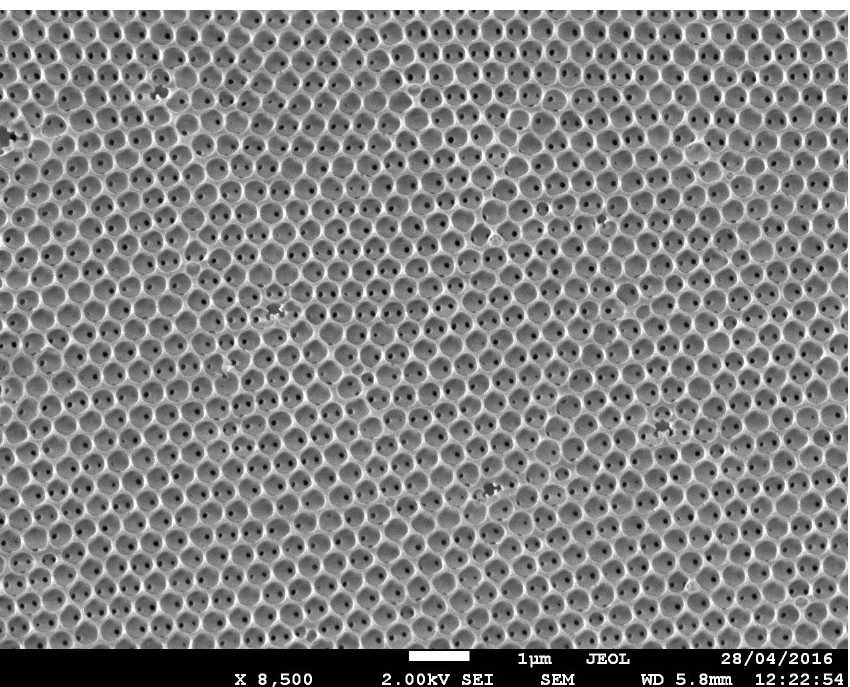
Figure 2. SEM image of inverse silica opal film obtained using co-assembly approach, showing high uniformity, with a diameter of the “holes” of about 370 nm.